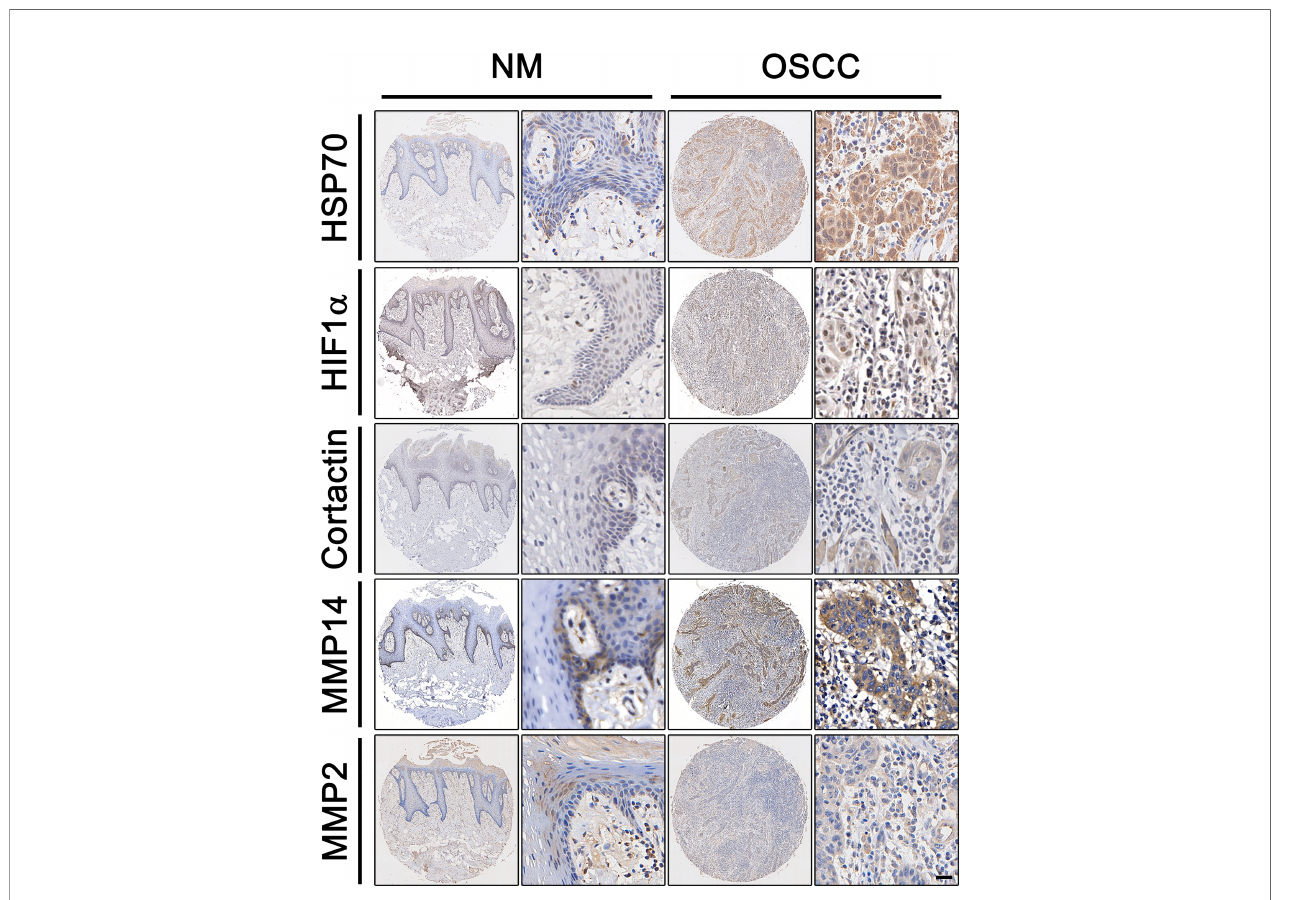
FIGURE 1 | Expression of HSP70, Hif1 a , MMP2, MMP14, and cortactin in OSCC. Representative immunohistochemical staining of HSP70, Hif1 a , MMP2, MMP14, and cortactin expression in oral squamous cell carcinoma (OSCC) and matched paracarcinoma (NM). Scale bar, 50 m